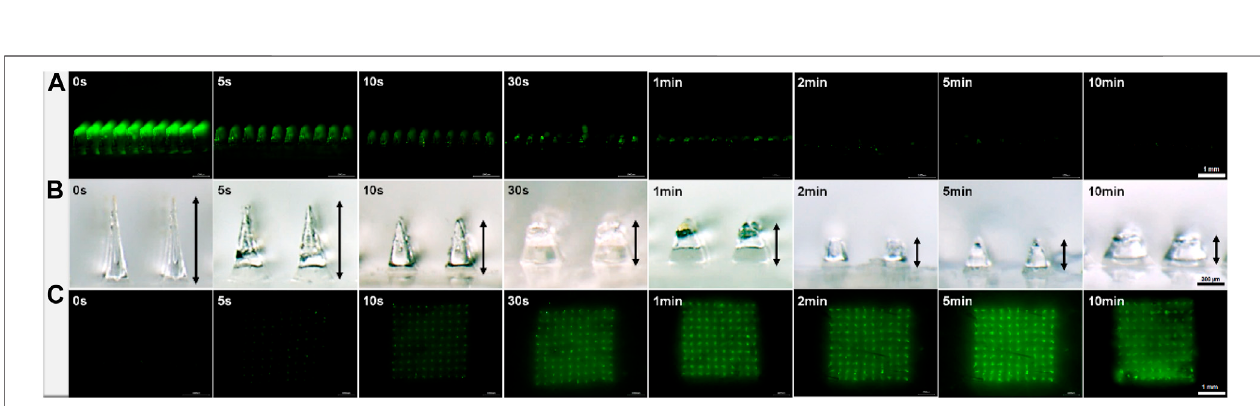
FIGURE 5 | Micrographs of MN arrays after inserting and embedding in subcutaneous tissue with different times (A, B) and the images of porcine skin after drug administration in vitro with different times (C) . Scale bar: 1 mm.